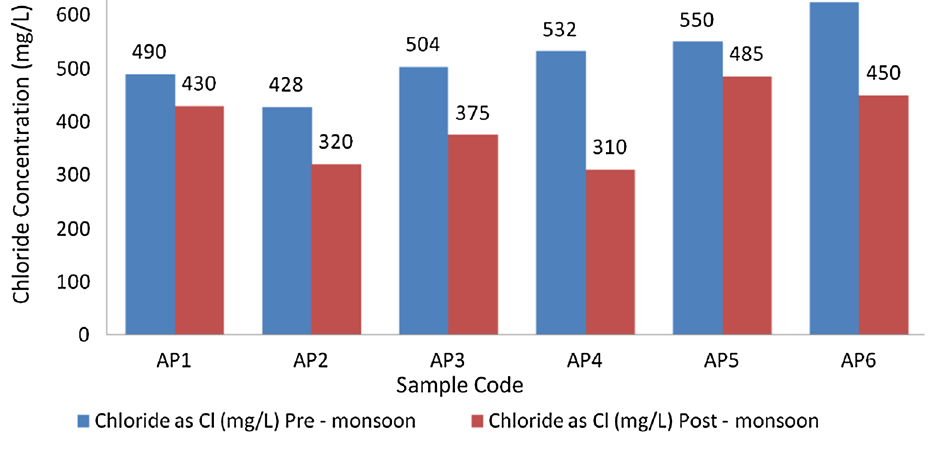
Fig. 7 Nitrate concentration in samples BIS limit (45 mg/L) collected from Pandav